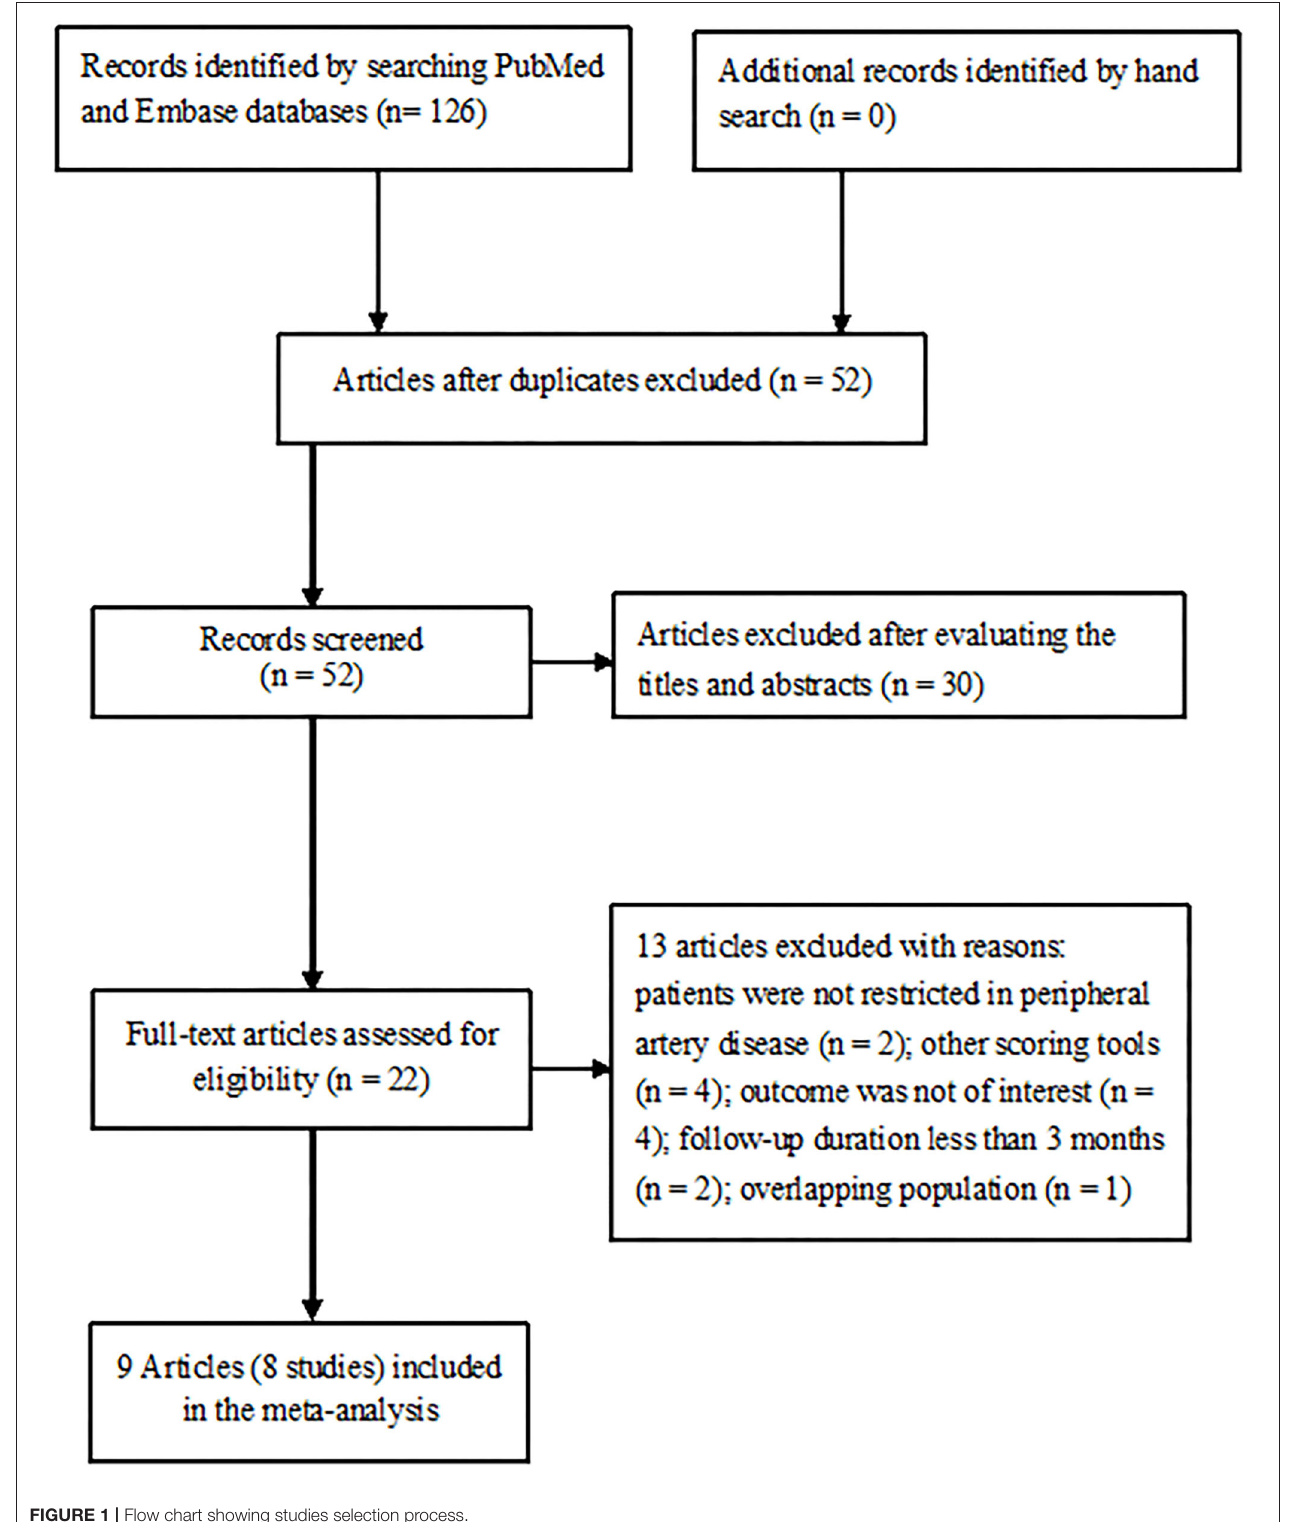
FIGURE 1 | Flow chart showing studies selection